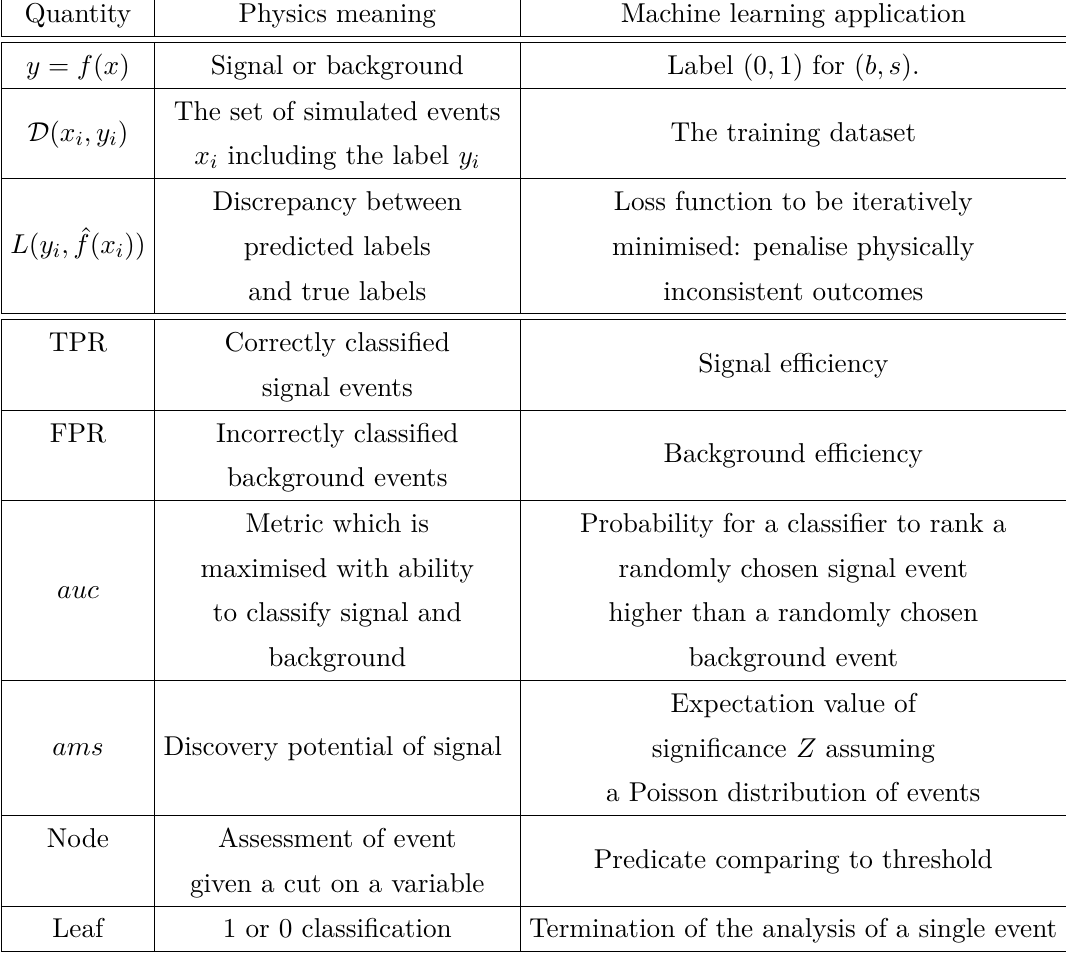
Table 2 . A dictionary of the terms and symbols appearing in this paper, including their context in both physics and machine-learning